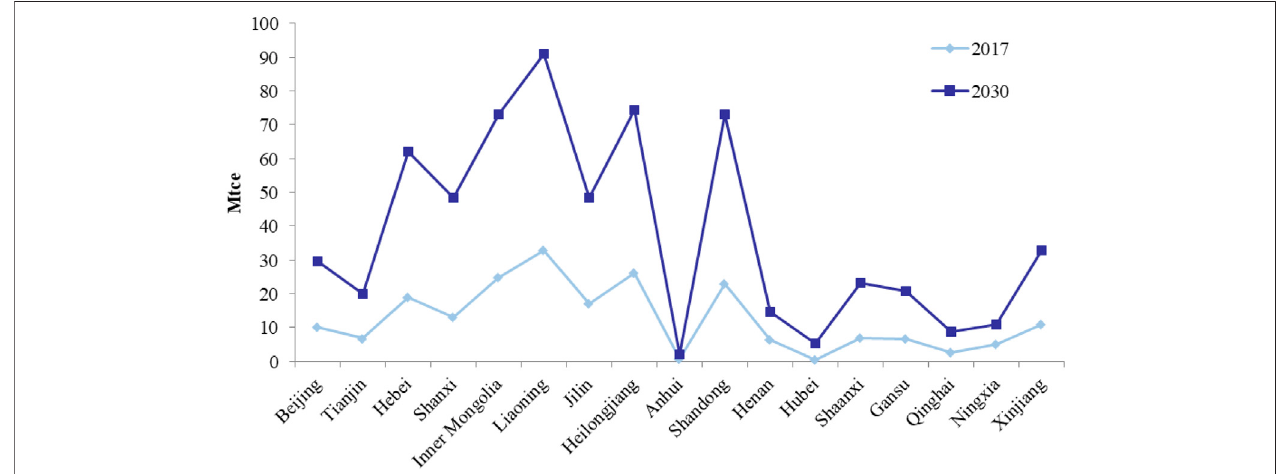
FIGURE 5 | Energy consumption of central heating in different provinces in